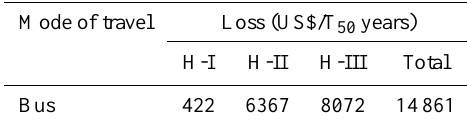
Table 10. Indirect risk due to additional ticket